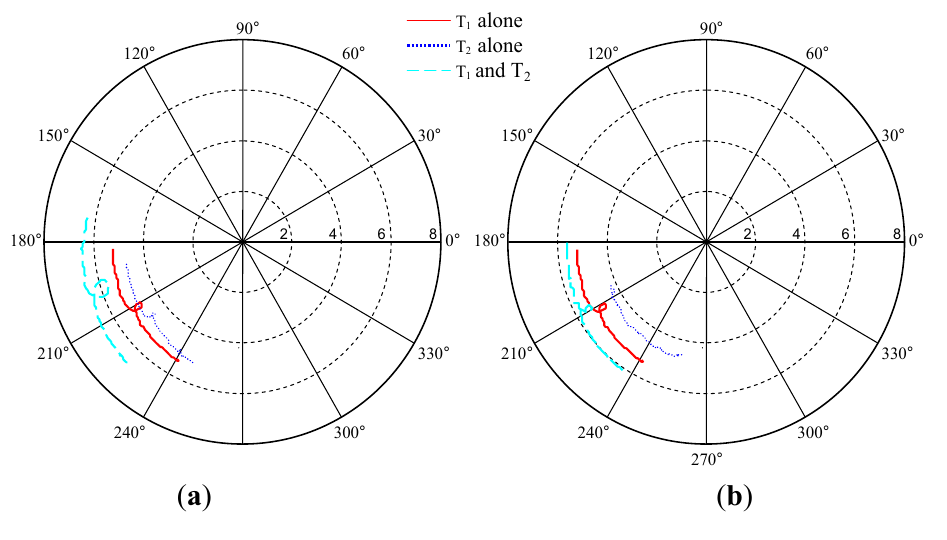
Figure 10. Measured signals for the three configurations, with T 1 fixed in front of the emitter and for T 2 placed ( a ) at y = 0.5 m or ( b ) at y = 1.3